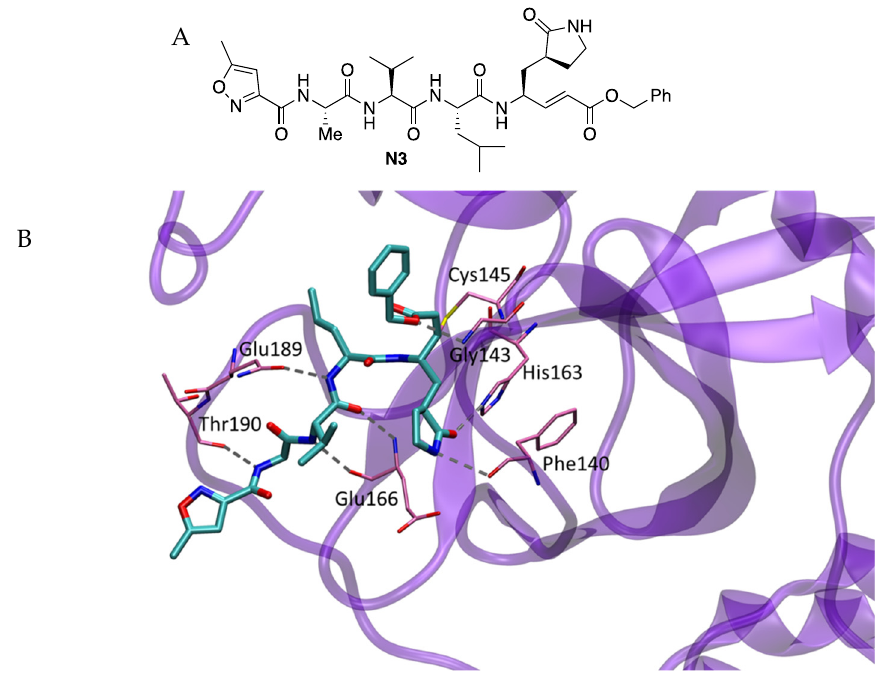
Figure 1. ( A ) Chemical structure of N3 inhibitor. ( B ) X ‐ ray structure of the complex between N3 and SARS ‐ CoV ‐ 2 Mpro.